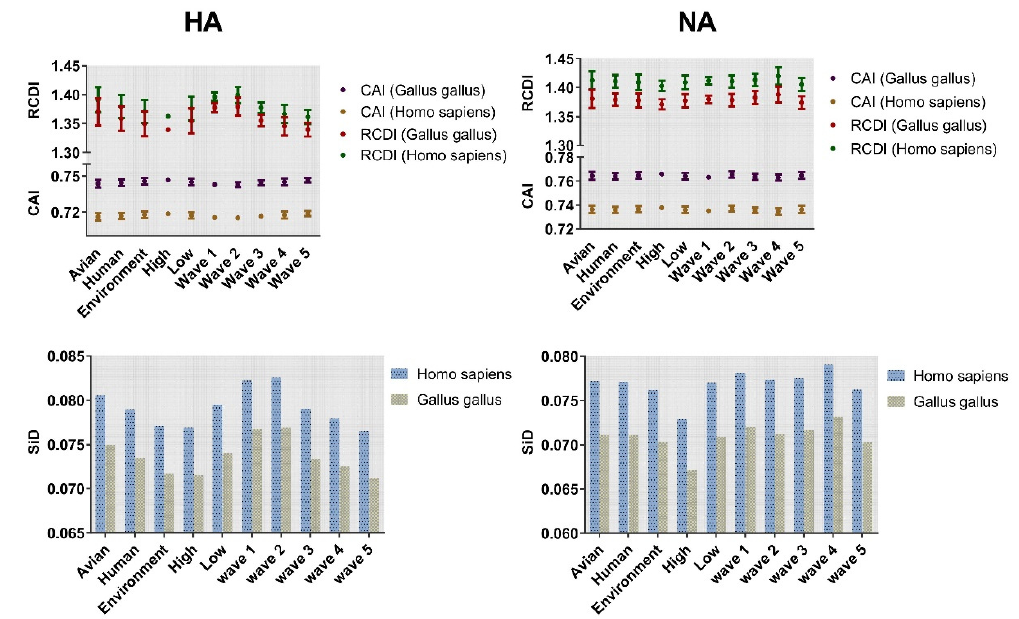
Figure 7. Codon adaptation index (CAI) and relative codon deoptimization index (RCDI) analysis of HA and NA. The coordinate axis was divided into two segments, and then placed the above two analyses on the same figure for observation. CAI corresponds to dark purple for avian and coffee for human. In RCDI, dark red and dark green represent Gallus gallus and Homo sapiens , respectively. Cylindrical maps are classified according to di ff erent taxonomy with SiD values as ordinates. Blue and yellow are used to represent Homo sapiens and Gallus gallus , respectively.